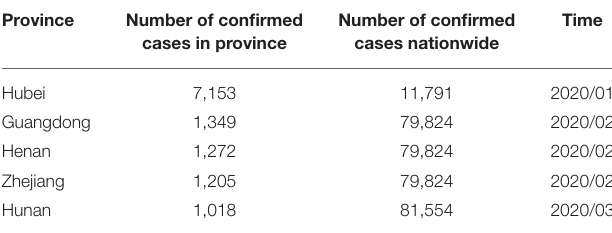
TABLE 1 | The time series of confirmed cases with a cumulative number of over 1,000 in the